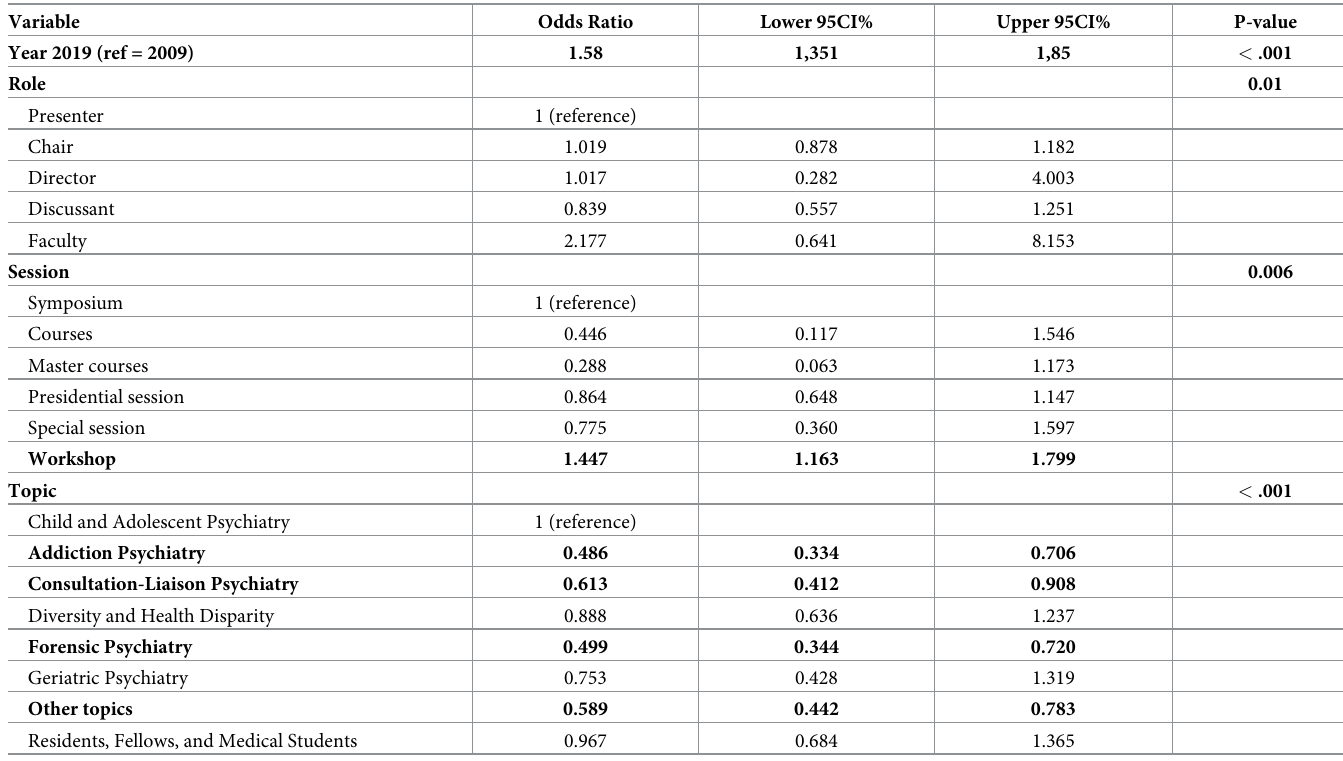
Table 2. Multivariable analysis by logistic regression modelling the probability of female participation according to APA